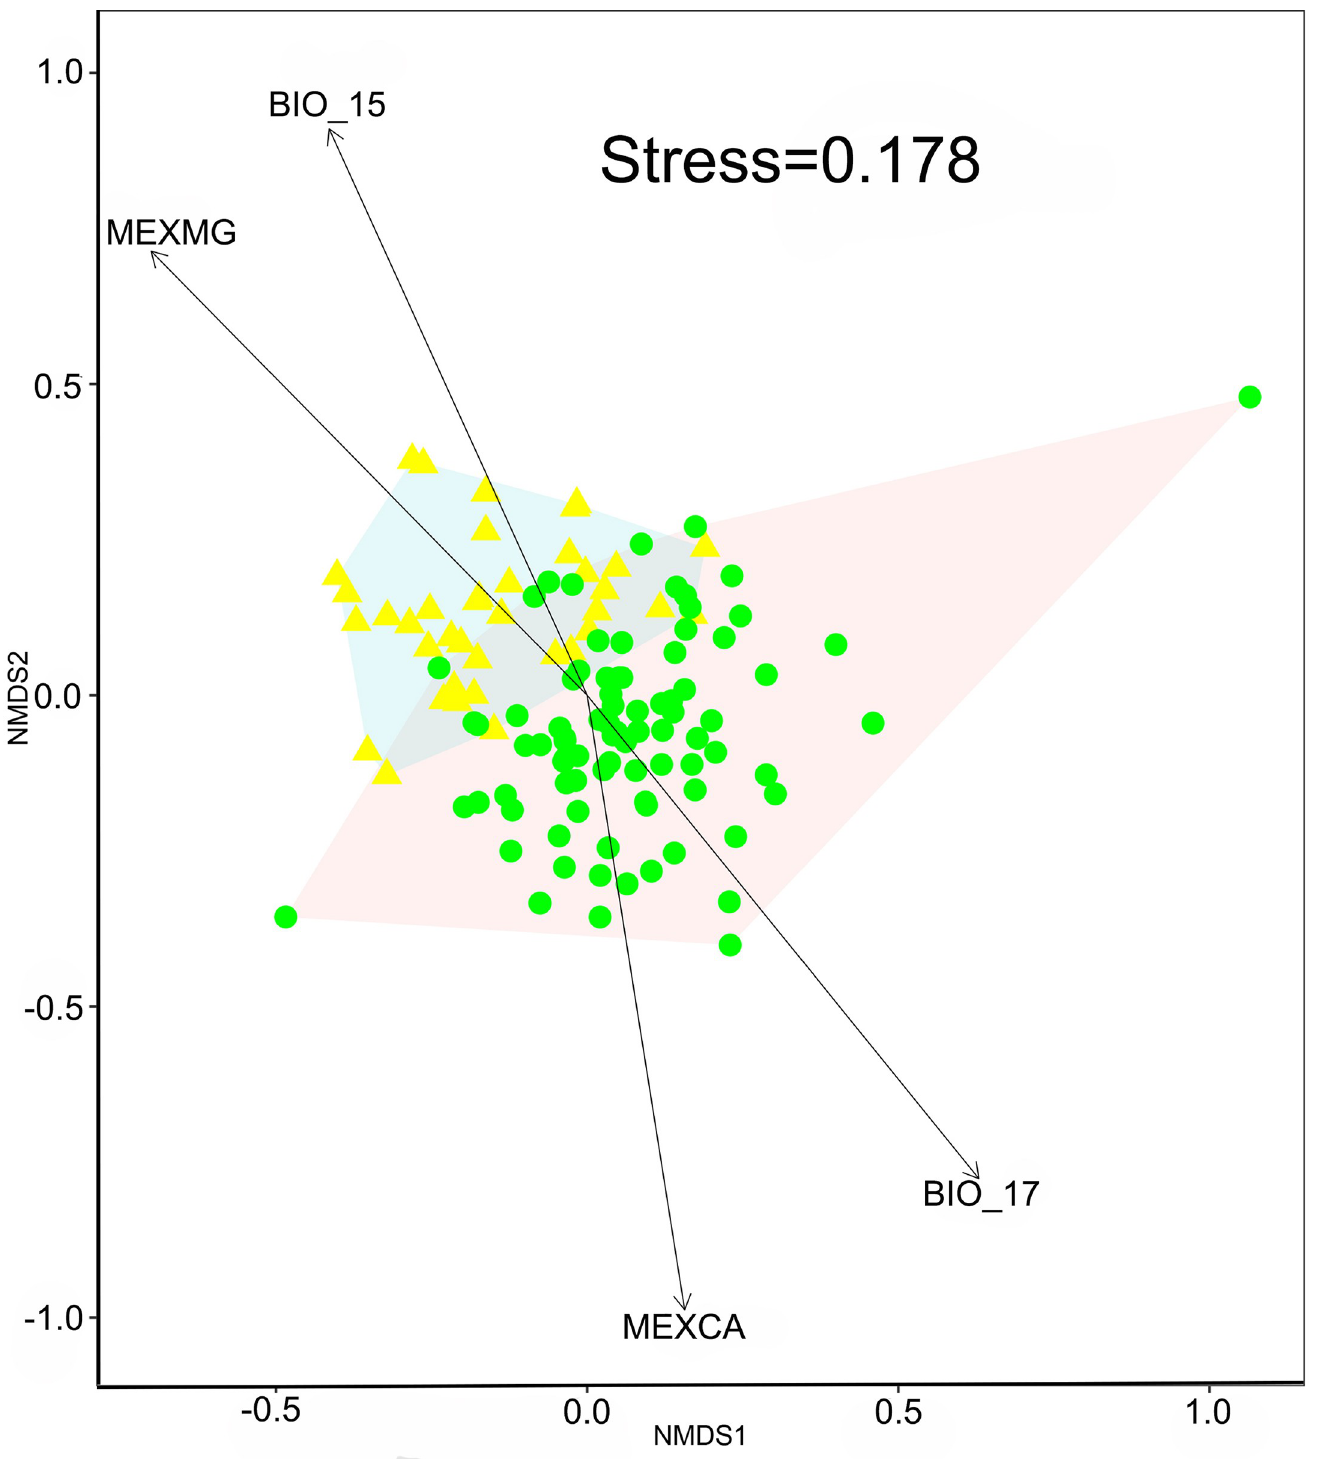
Fig 6. NMDS ordination and environmental predictors (vectors) as predictors of environmental turnover, calculated for 122 grid cells, distributed along the Balsas Depression, Mexico. The vectors shown include only the variables with a significant effect ( p < 0.001) on the NMDS ranking. BIO_15: Precipitation Seasonality (coefficient of variation in %); BIO_17: Precipitation of the driest four-month period; MEXMG: Magnesium content; MEXCA: Calcium content. The circles correspond to the grid cells of the Upper Balsas and the triangles to the cells of the Lower Balsas.